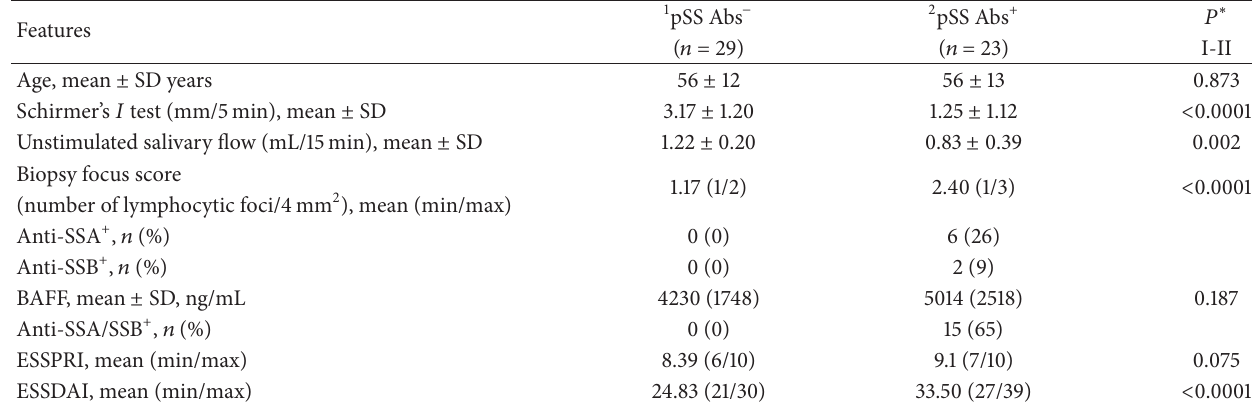
Table 1: Clinical and serological characteristics of pSS